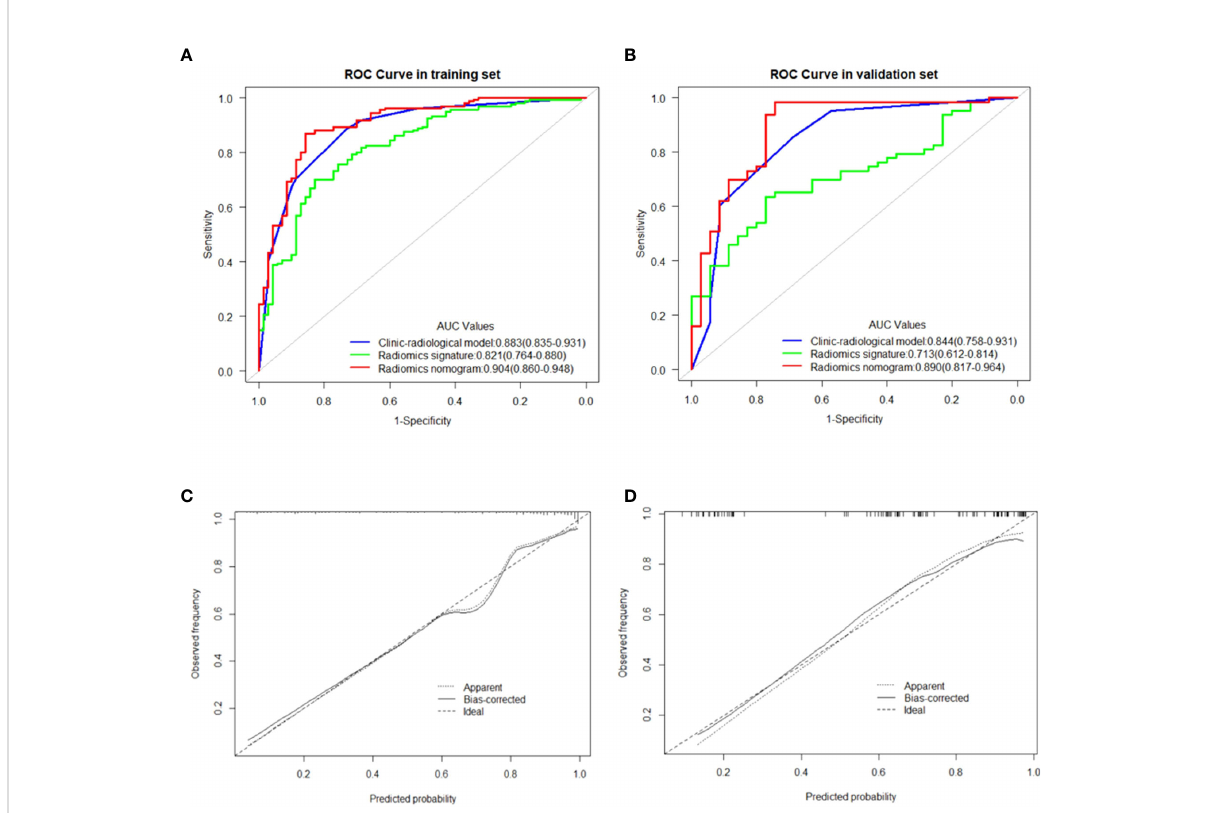
FIGURE 5 (A, B) showed the comparison of receiver operating characteristic curves between the clinic-radiological model, radiomics signature and radiomics nomogram in the training and validation cohorts, respectively. Calibration curves of the radiomics nomogram in the training cohort (C) and validation cohort (D) . The 45 straight line represents a perfect match between the actual (Y-axis) and nomogram-predicted probabilities (X-axis), and the dotted lines represent the predictive performance of the